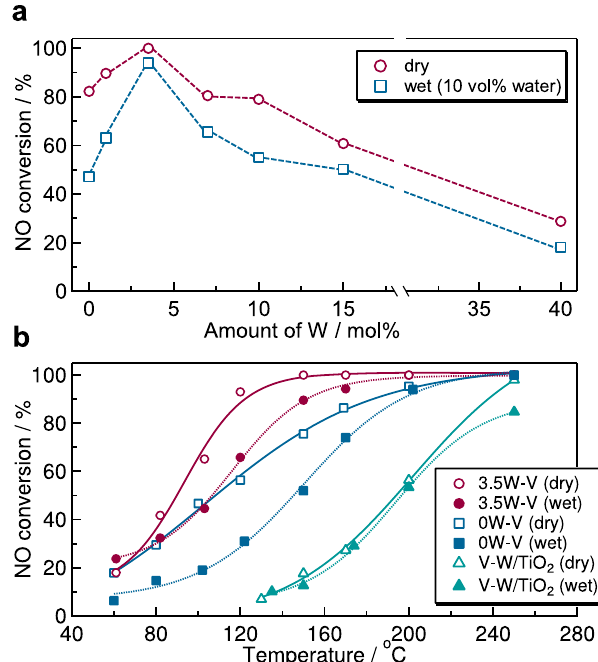
Fig. 3 NH 3 -SCR activity of W-substituted vanadium oxide catalysts. a NO conversion (150 °C) of W-substituted vanadium oxide catalysts as a function of the molar ratio of tungsten. b NO conversion of 3.5W – V (W- substituted vanadium oxide), 0W – V (without tungsten), and V – W/TiO 2 (model of a conventional catalyst) as a function of reaction